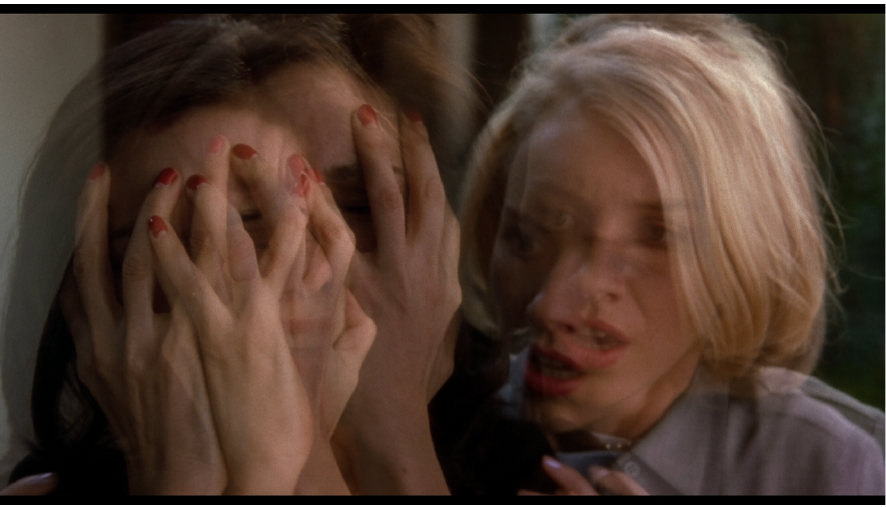
Figure 5: Reality collapses on Diane’s fantasy as Camille and Betty clash into each other. Where Lacan Comes